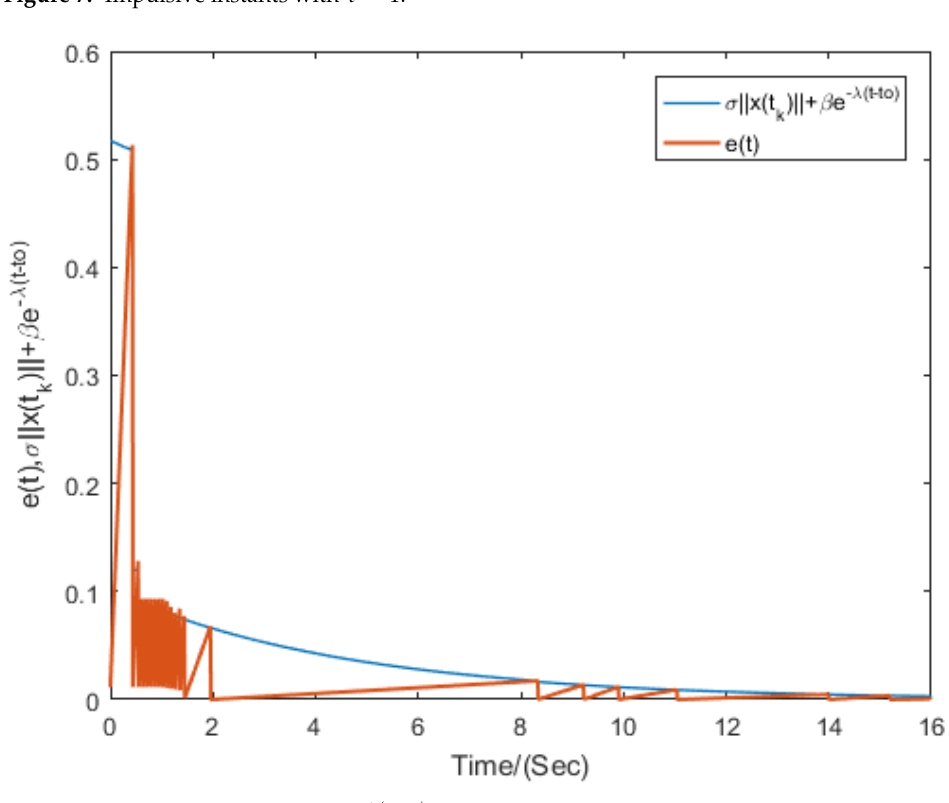
Figure 7. Impulsive instants with τ = 1.